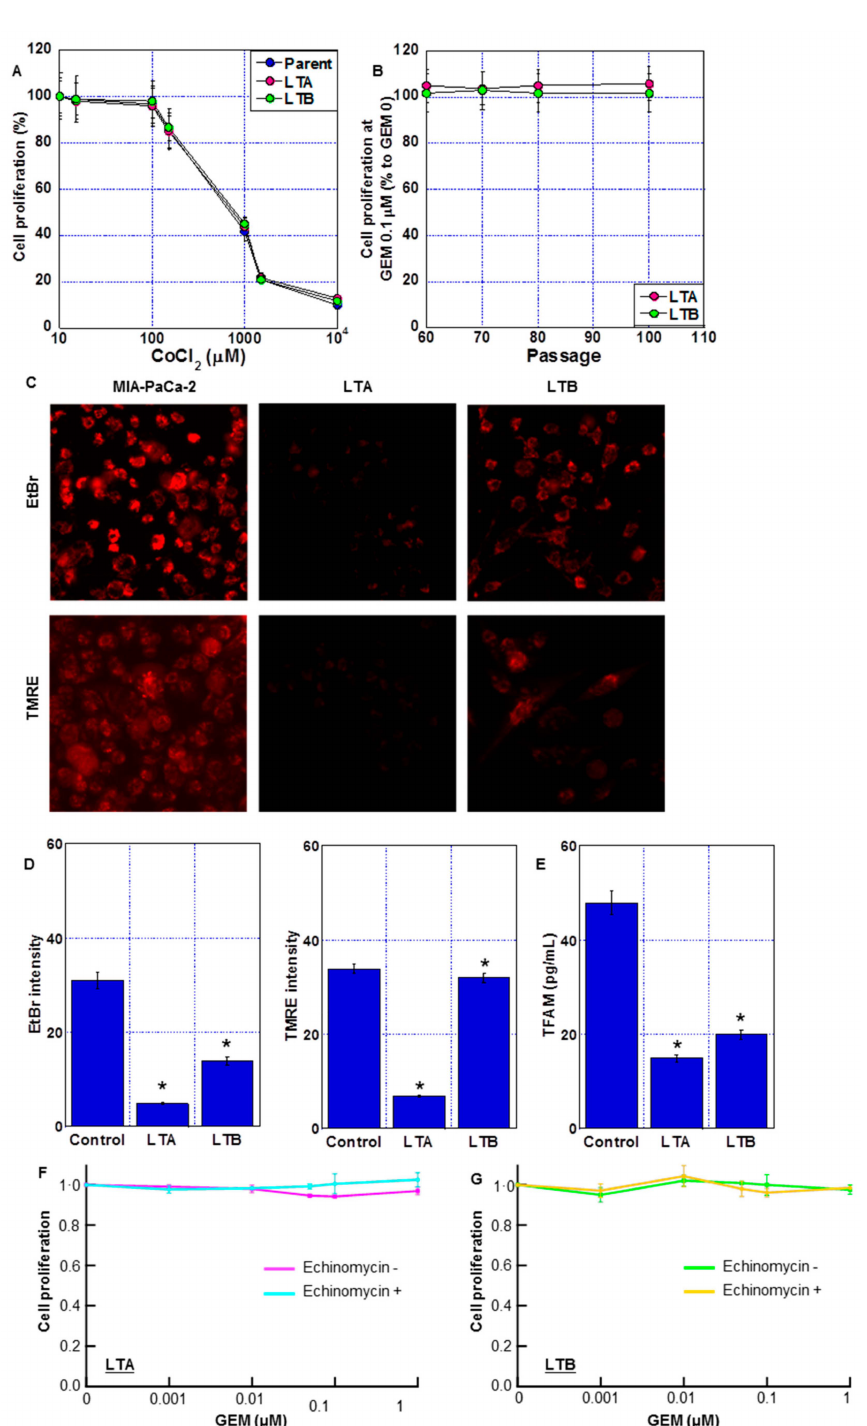
Figure 5. Mitochondrial impairment in long-term hypoxia-induced GEM-resistant PDA cells. ( A ) Effect of CoCl 2 on cell proliferation of LTA and LTB cells. ( B ) GEM resistance after cessation of GEM and CoCl 2 treatment. ( C ) Fluorescent images of mitochondria DNA (EtBr) and mitochondrial membrane potential (TMRE). Scale bar, 50 µ m. ( D ) Semi-quantification of mitochondrial EtBr and TMRE signals. ( E ) TFAM levels were measured by ELISA. Error bars represent the standard